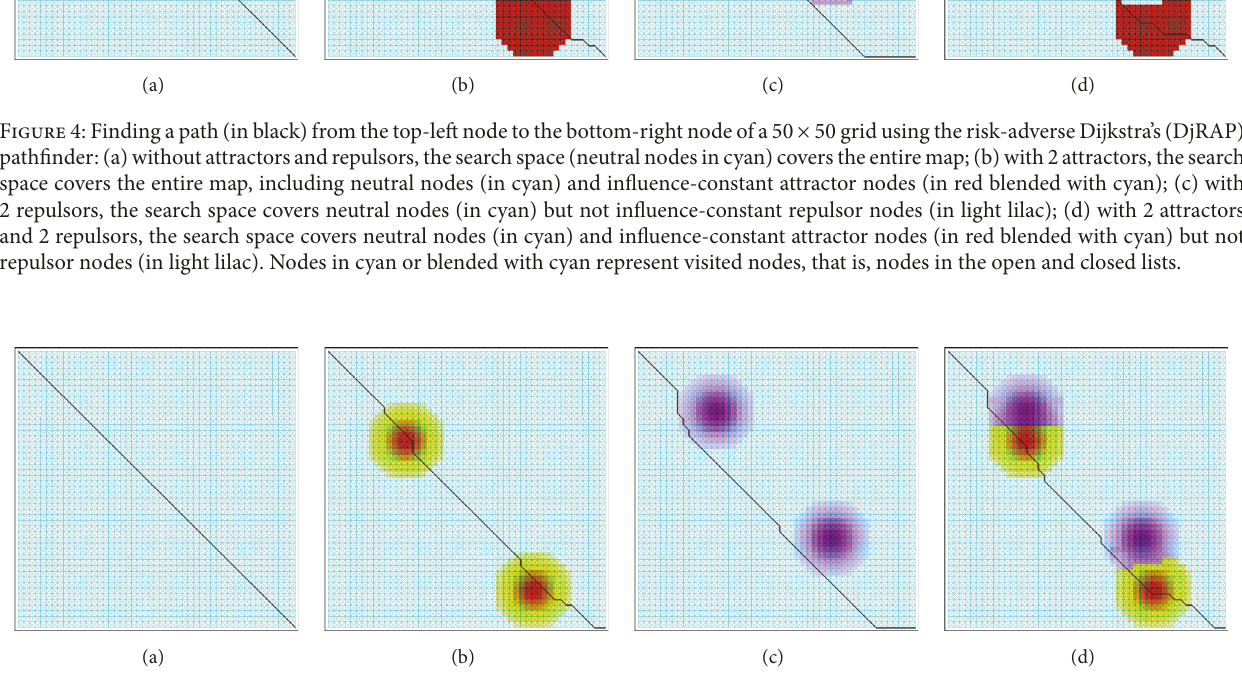
Figure 5: Finding a path (in black) from the top-left node to the bottom-right node of a 50 × 50 grid using the constraint-aware navigation Dijkstra’s (DjCAN) pathfinder: (a) without attractors and repulsors, the search space (neutral nodes in cyan) covers the entire map; (b) with 2 attractors, the search space also covers the entire map, including neutral nodes (in cyan) and attractor nodes (in red-to-yellow blended with cyan); (c) with 2 repulsors, the search space again covers the entire map, including neutral nodes (in cyan) and repulsor nodes (those in purple blue as a result of blending dark-lilac-to-light lilac with cyan); (d) with 2 attractors and 2 repulsors, the search space covers the entire space, including neutral nodes (in cyan), attractor nodes (in red-to-yellow blended with cyan), and repulsor nodes (in purple blue). Nodes in cyan or blended with cyan represent visited nodes, that is, nodes in the open and closed